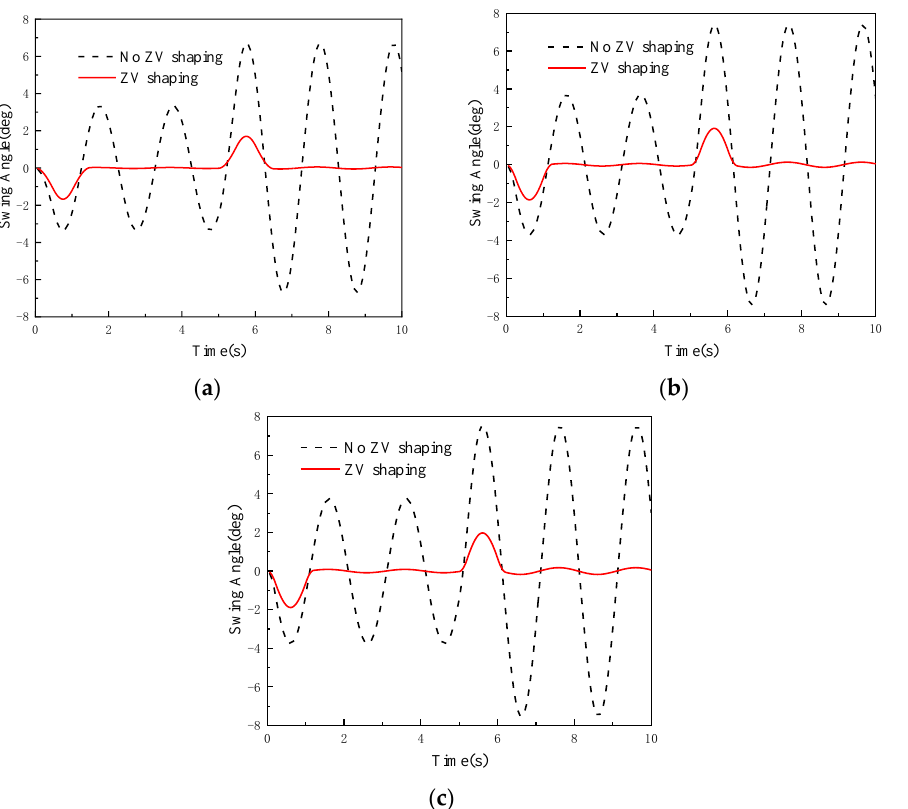
Figure 11. Digital twin RMGC for virtual testing.